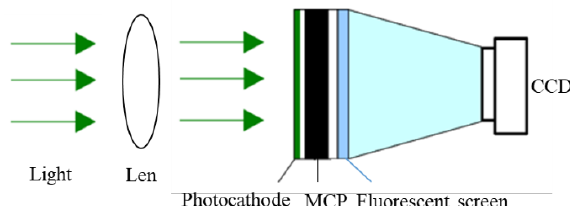
Figure 2. Composition of the receiver in the PLRGI system.